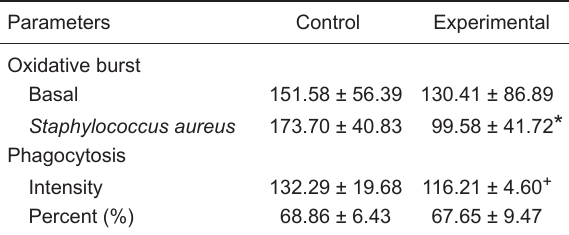
Table 1. Effects of cyhalothrin (3 mg/kg for 7 days) on peritoneal macrophages activated by Ehrlich ascitic tumor cells in mice.